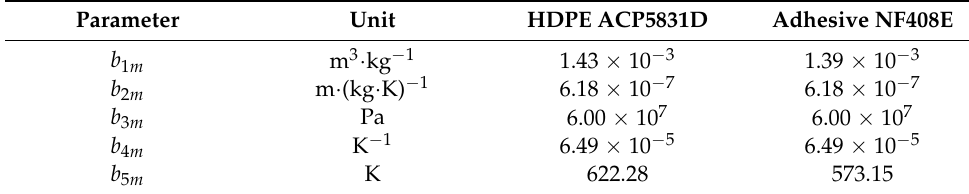
Table 4. To be able to perform both OCT and ultrasonic measurements, two exchangeable